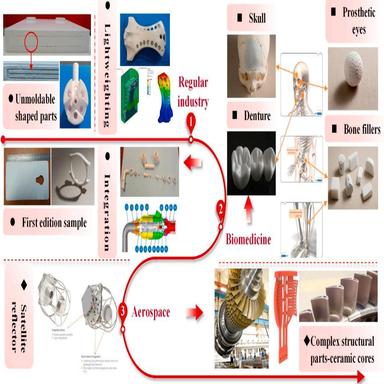
Application of ceramic additive manufacturing technology.